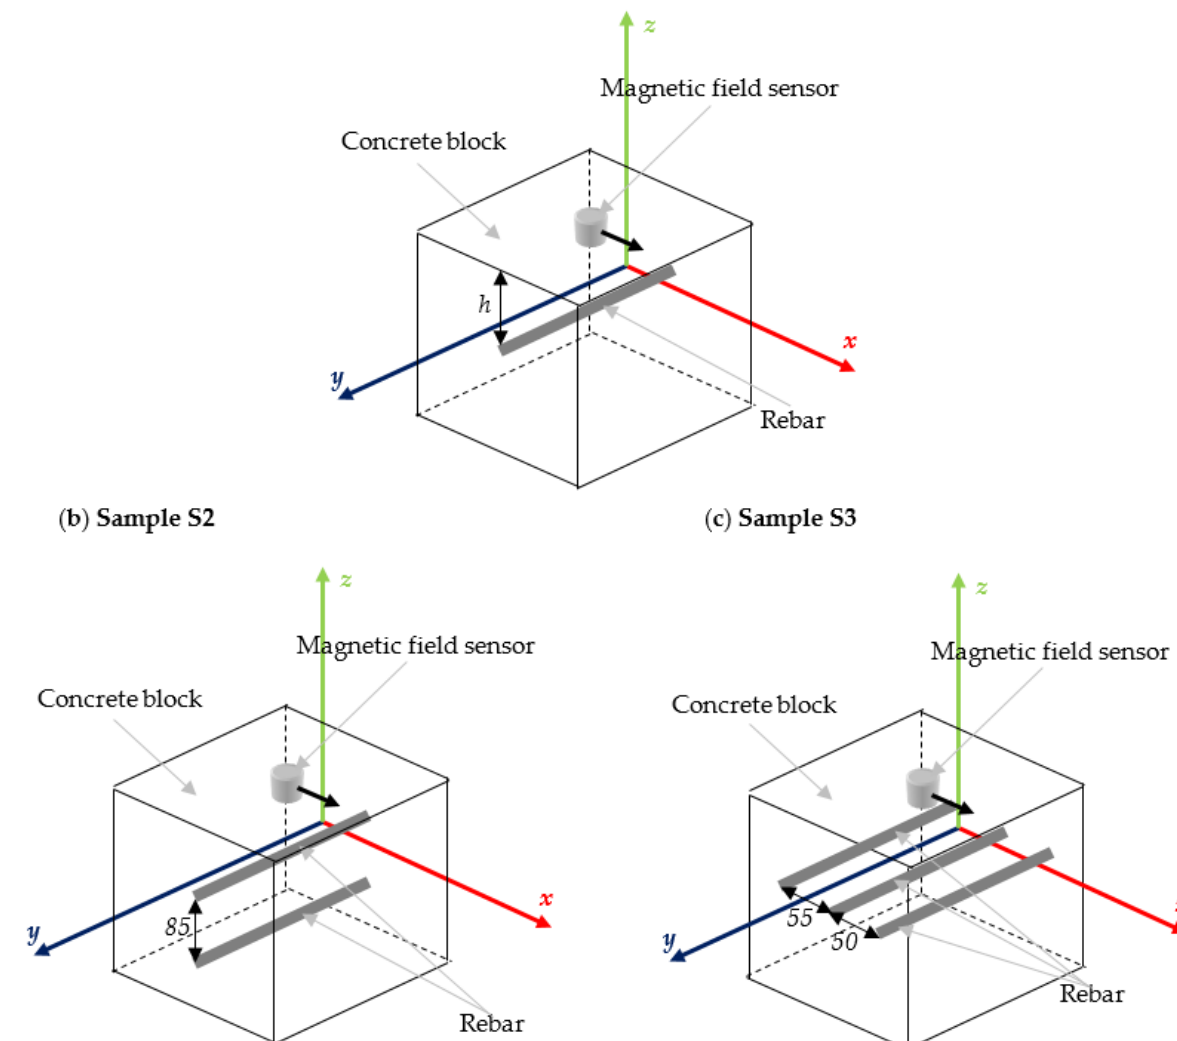
Figure 3. The samples used in the experiments; ( a ) sample S1 (with single rebar); ( b ) sample S2 (with two rebars one under the other); ( c ) sample S3 (with three rebars next to each other).